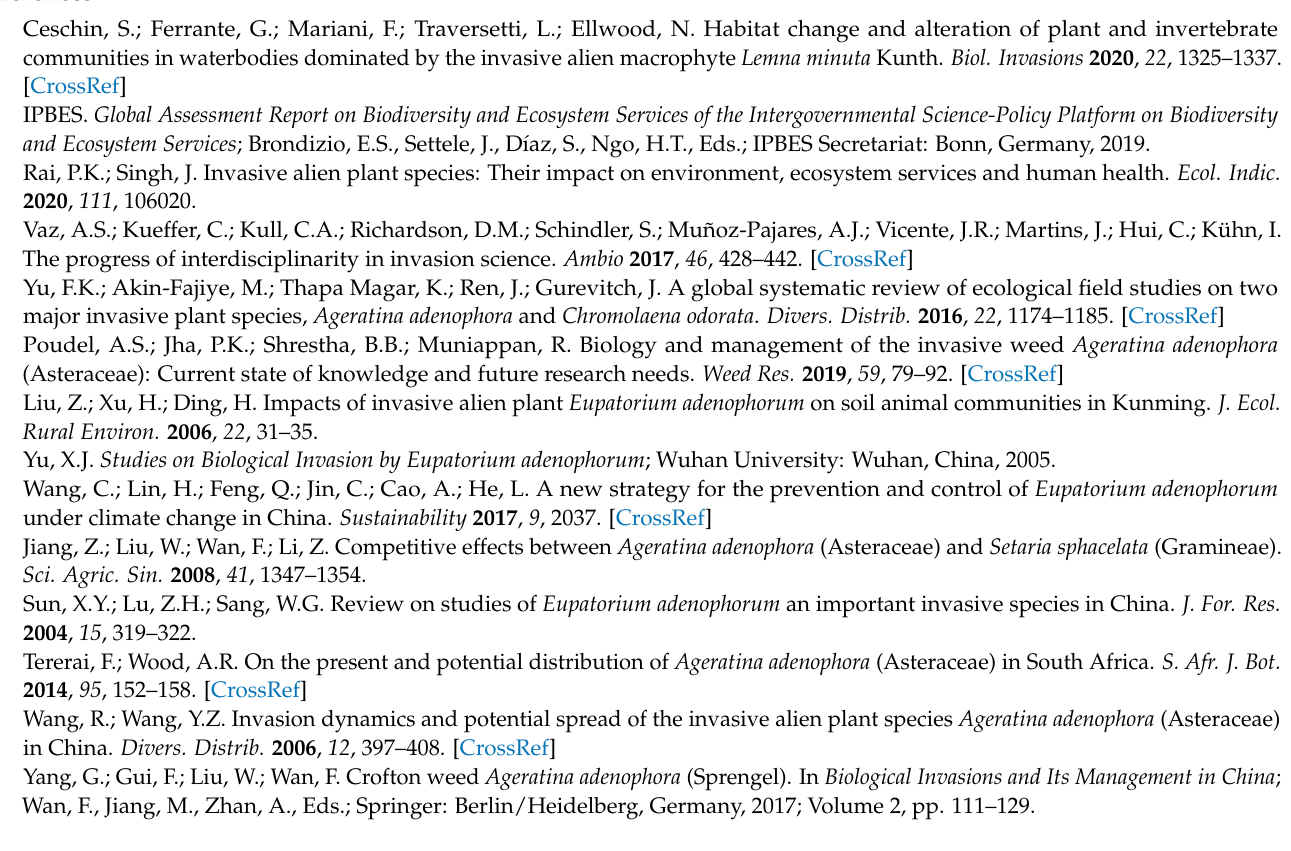
Figure S1: Vegetation types on the south- and north-facing slopes of Mount Nyba. (a) Low shrubs growing on the south-facing slope. (b) Lush forests growing on the north-facing slope. Both pictures were captured on January 26, 2022; Figure S2: Geographical locations of records of A. adenophora . The study area was limited to 85.73–113.01 ◦ E and 19.59–36.49 ◦ N, marked by red frame; Figure S3: Figure S4: Comparison of solar radiation between Hanyuan and Yingjing Counties. Student’s t -test: ** p < 0.01; Video S1: Dynamic expansion process of A. adenophora in each year from 1950 to 2020 using the MigClim